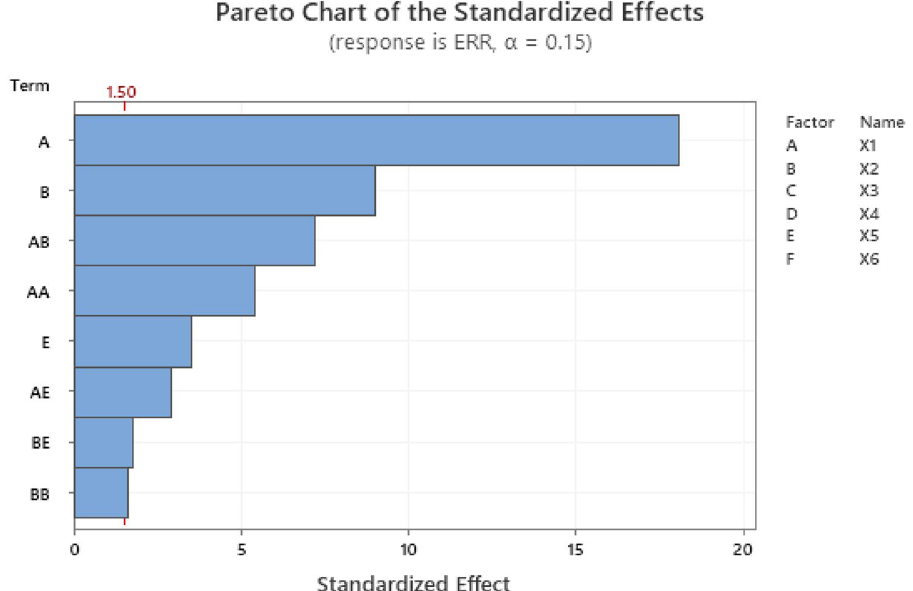
Fig. 14 Pareto chart of stand- ardized effects of inputs on ERR